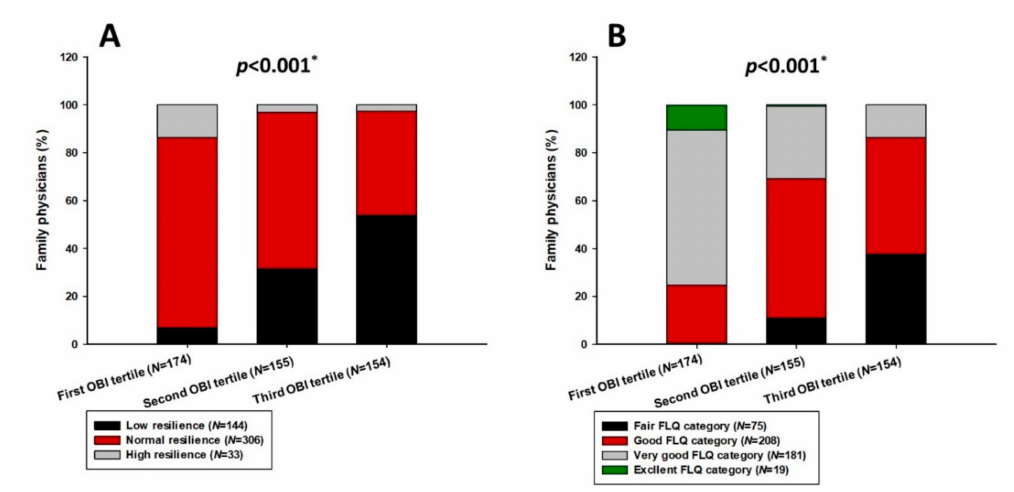
Figure 2. Resilience categories according to BRS scale ( A ) and healthy lifestyle categories according to FLQ scale ( B ) in OBI total score tertiles in study population; BRS—Brief Resilience Scale; FLQ— Fantastic Lifestyle Questionnaire; OBI—Oldenburg Burnout Inventory; * chi-square